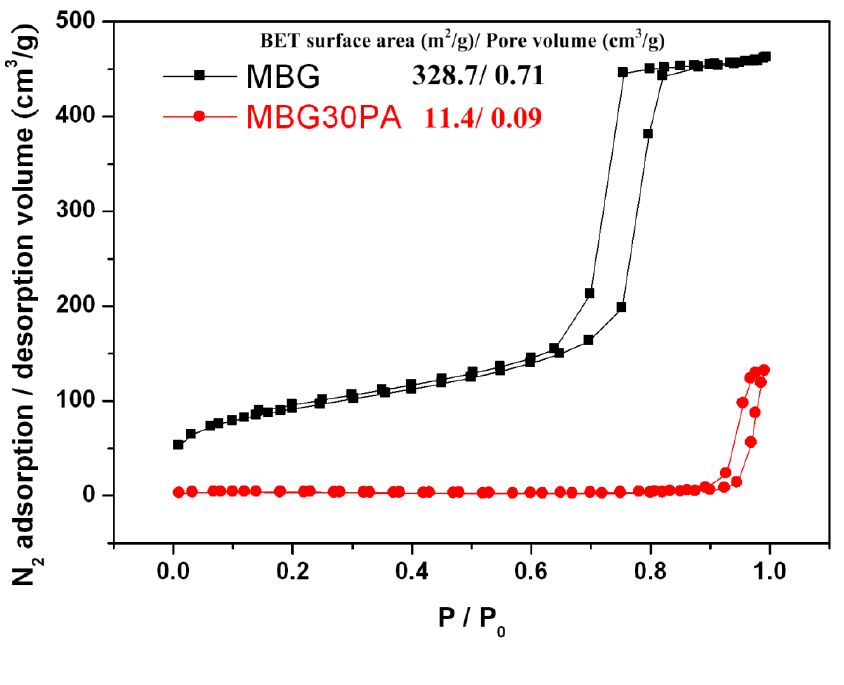
Figure 5. Nitrogen adsorption/desorption isotherm and the BET surface area with pore volume of MBG before and after mixed with 30%